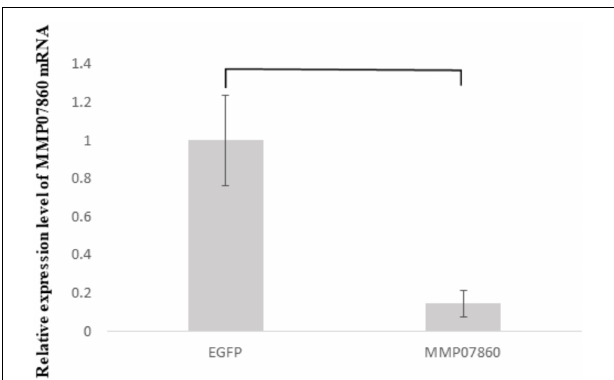
FIGURE 3 | Expression levels of MMP07860 mRNA in the mantle isthmus, determined using real-time quantitative polymerase chain reaction (qPCR) 12 h after injection. The injection of dsRNA (MMP07860) depressed the expression level of MMP07860. The MMP07860 mRNA expression in the EGFP group (EGFP–dsRNA injected) was given a relative value of 1.0. Five oysters ( n = 5) were used. Statistically significant differences were determined by t -test ( p < 0.05).